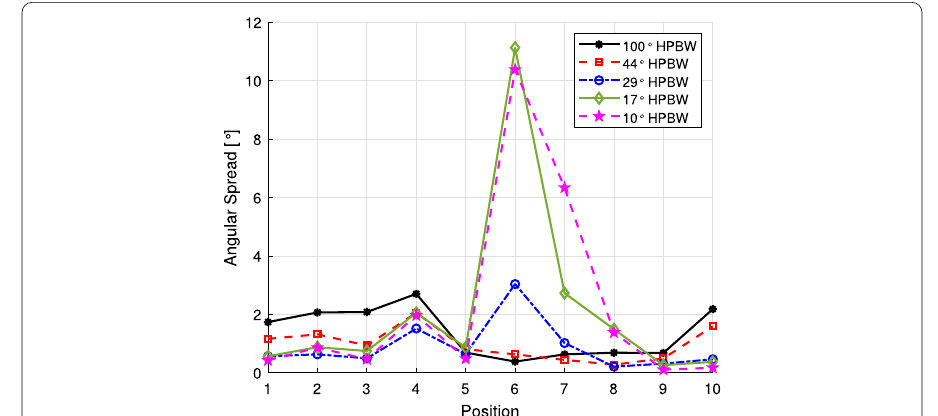
Fig. 13 Root mean square angular spread at receiver positions with different antenna